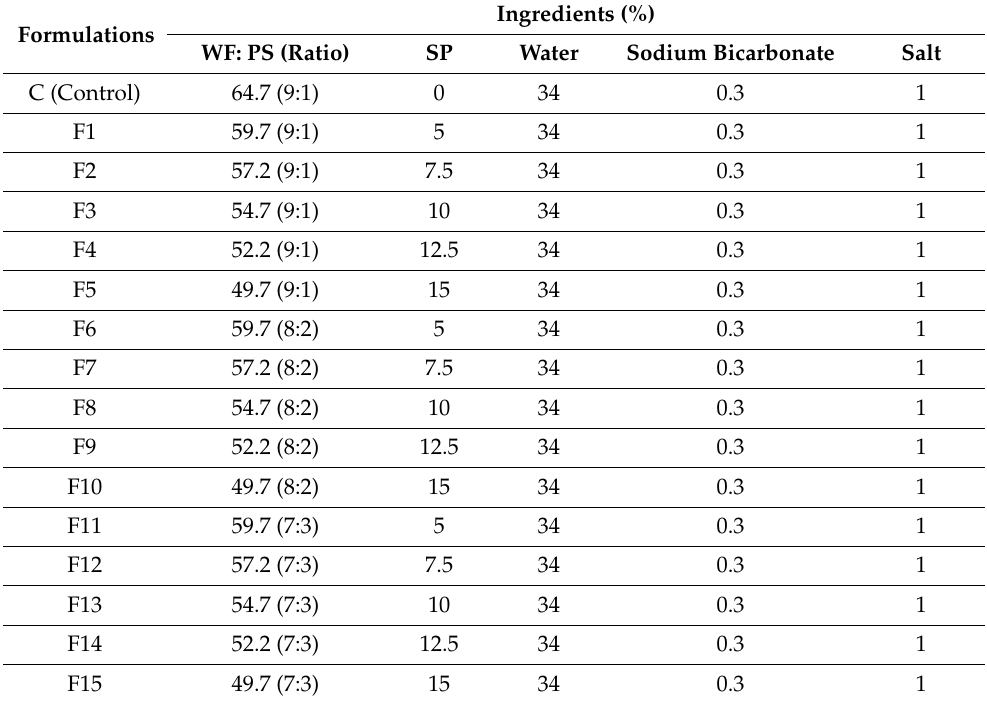
Table 1. Formulation of noodles with the variation of seaweed powder content.